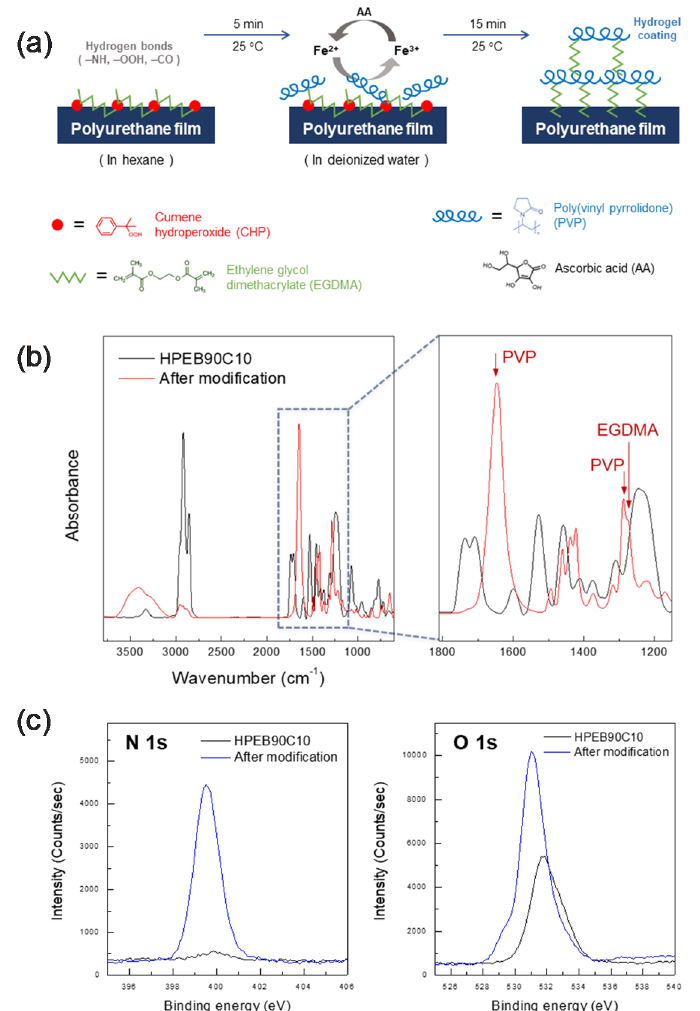
Figure 5. ( a ) Schematic illustration of PVP hydrogelation process using Fenton reaction on the sur- face of polyurethane copolymers. ( b ) comparison of FT-IR spectra for HPEB90C10 before and after PVP hydrogelation. ( c ) comparison of XPS spectra for HPEB90C10 before and after PVP hydrogela- tion.